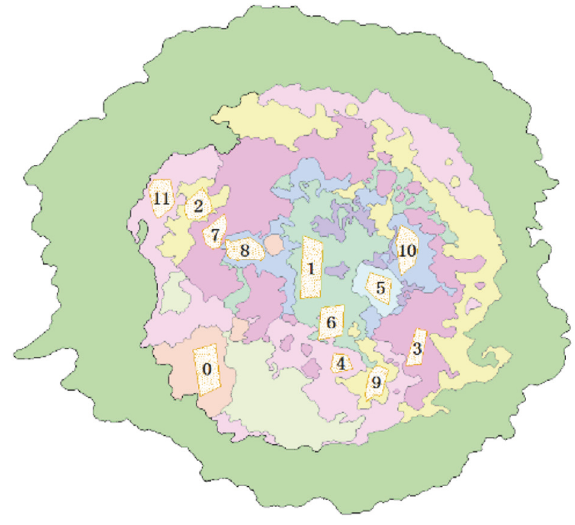
Figure 11: Samples for